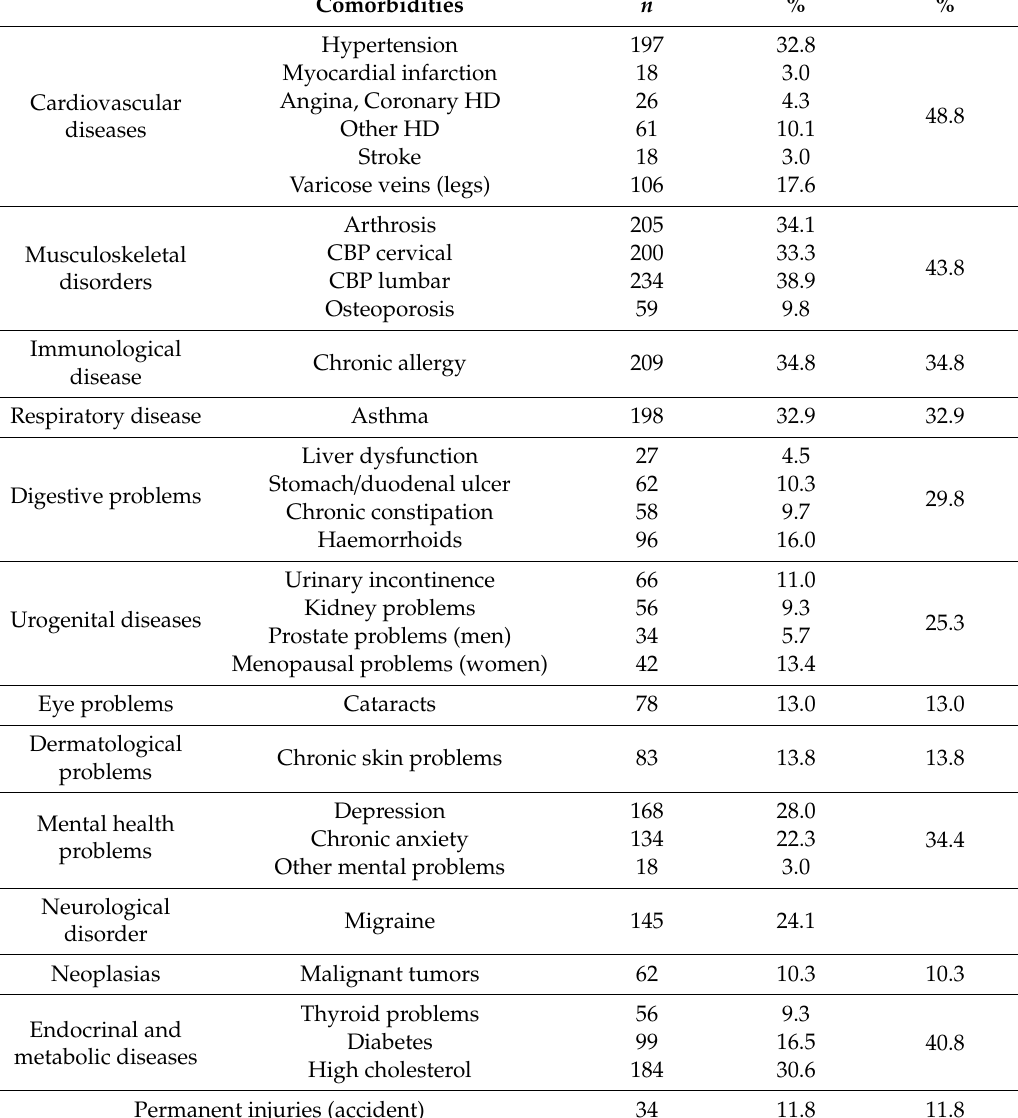
Table 2. Prevalence of comorbidities in people with